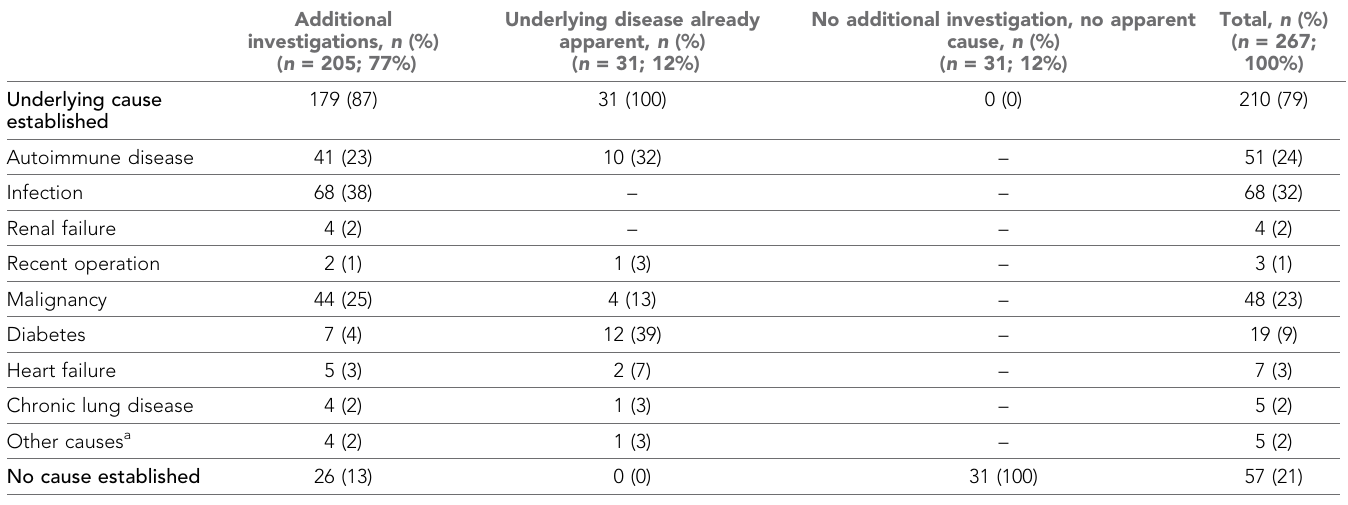
Table 3. Underlying causes of anaemia of chronic disease Additional investigations, n (%)